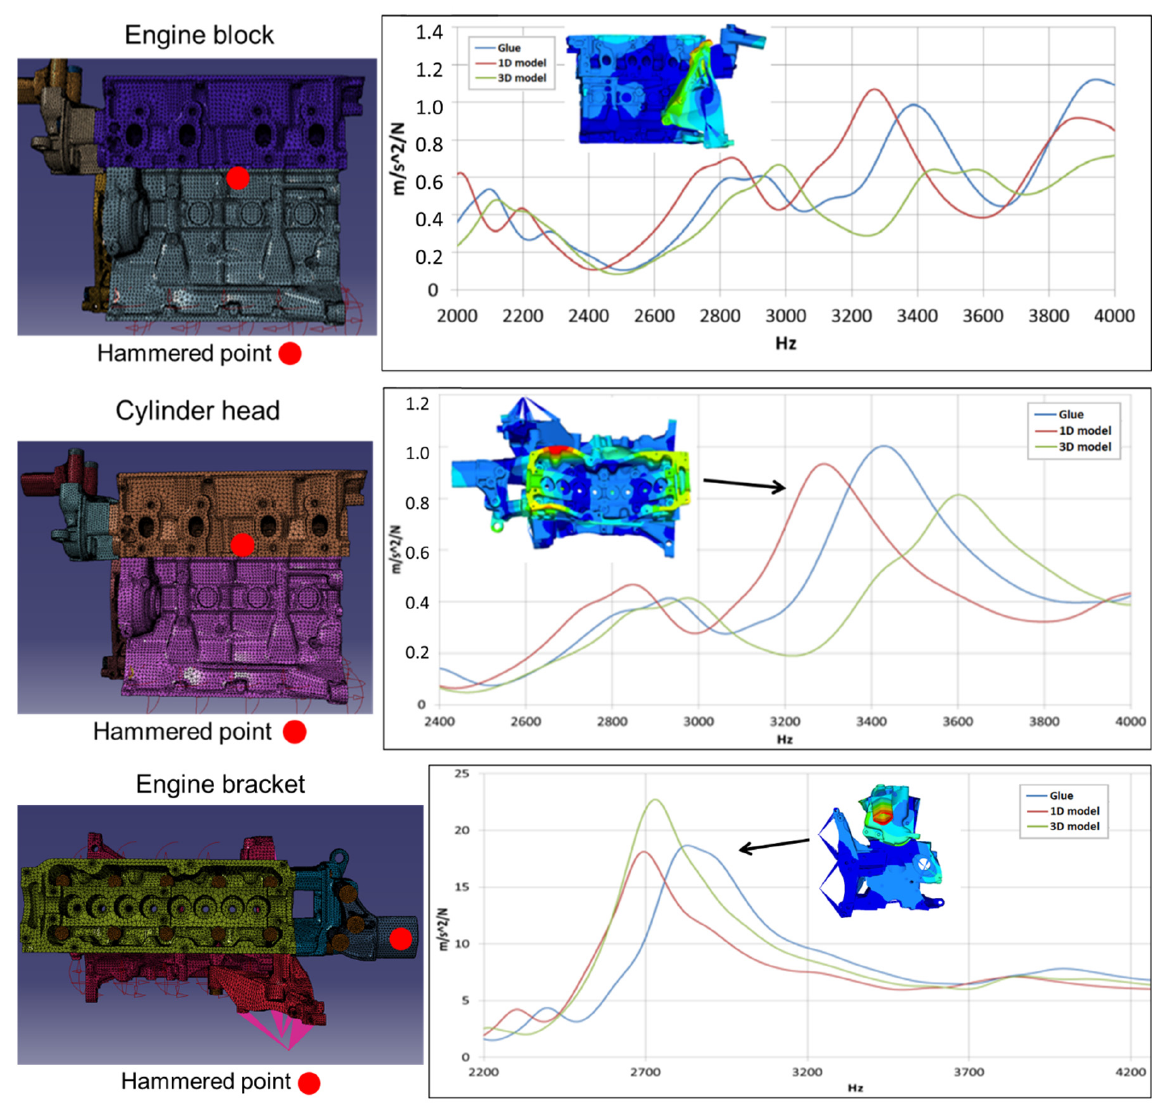
Figure 7. FRFs in the frequency range 0–2000 Hz, for the four hammered positions with highlight of eigenmodes related to the highest resonance amplitudes.